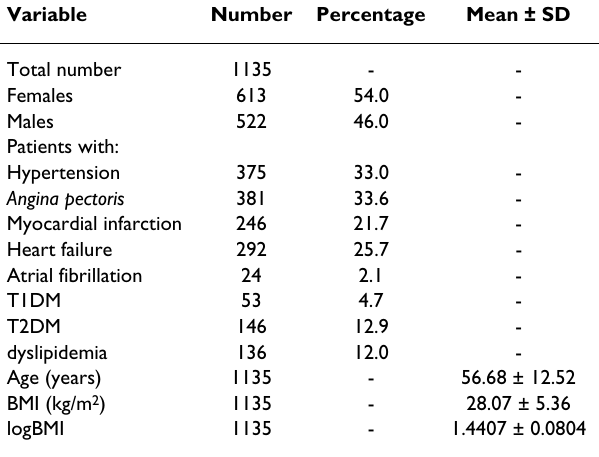
Table 1: Characteristics of the study